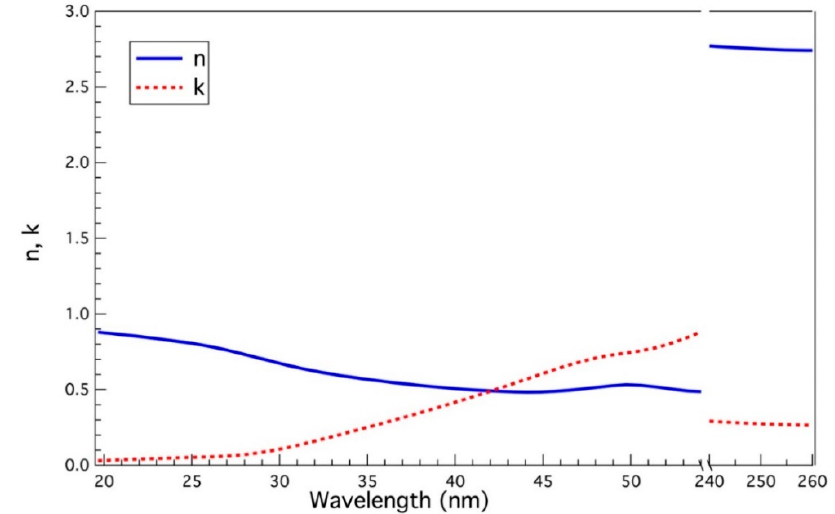
Figure 3. Values of the real (n, blue solid line) and imaginary optical constants (k, red dashed line) for an amorphous carbon thin film are shown for the relevant pump and probe wavelengths. Taken from [27].